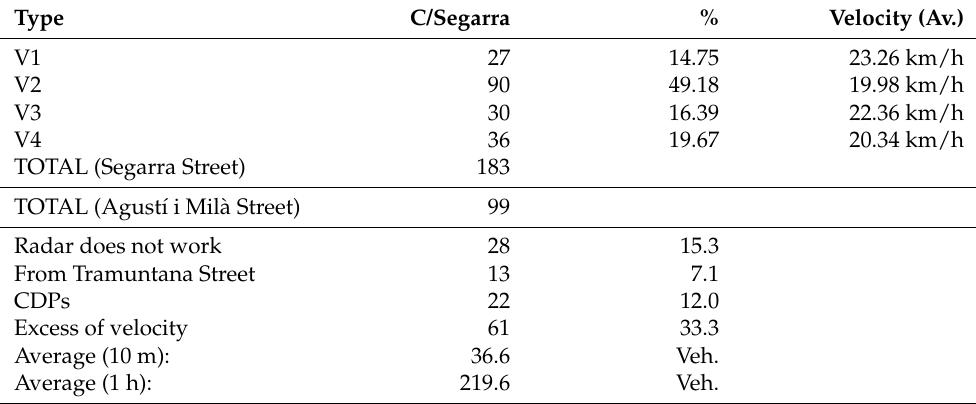
Table 7. Qualitative sample summary for Segarra Street by type of